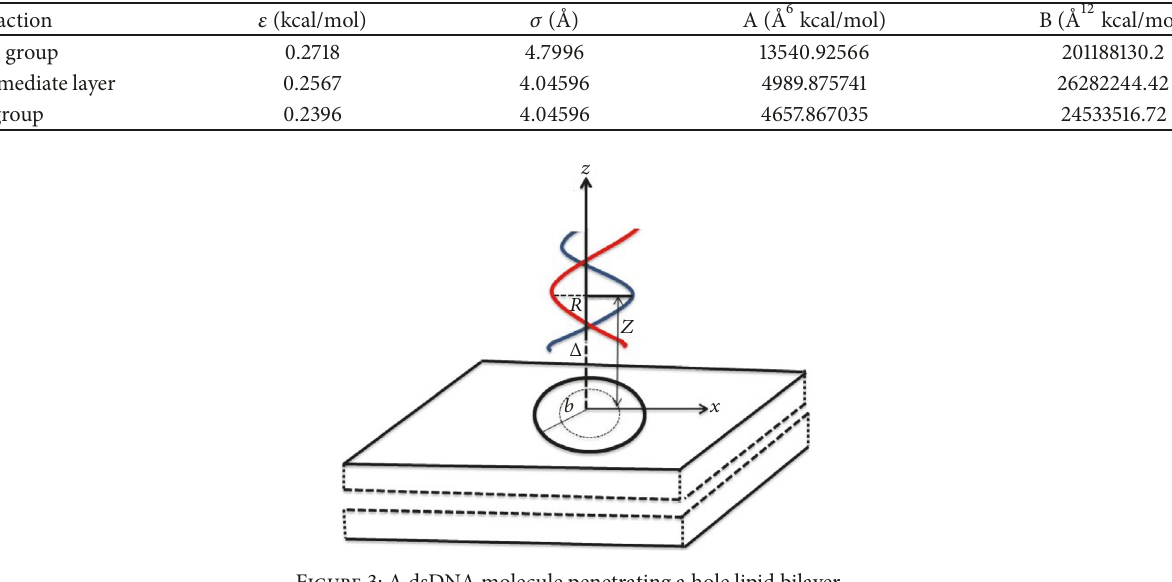
Figure 3: A dsDNA molecule penetrating a hole lipid bilayer.